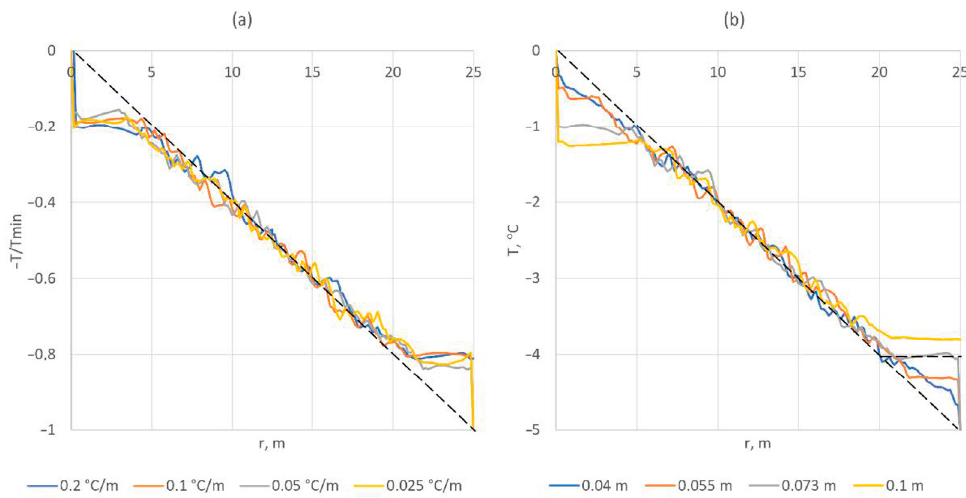
Figure 9. Temperature distributions along the borehole axis for impermeable walls at both ends of the borehole with different temperature gradients G ( a ) and different borehole diameters ( b ). For convenience, dimensionless temperature is marked along the Y axis in Figure 9a.